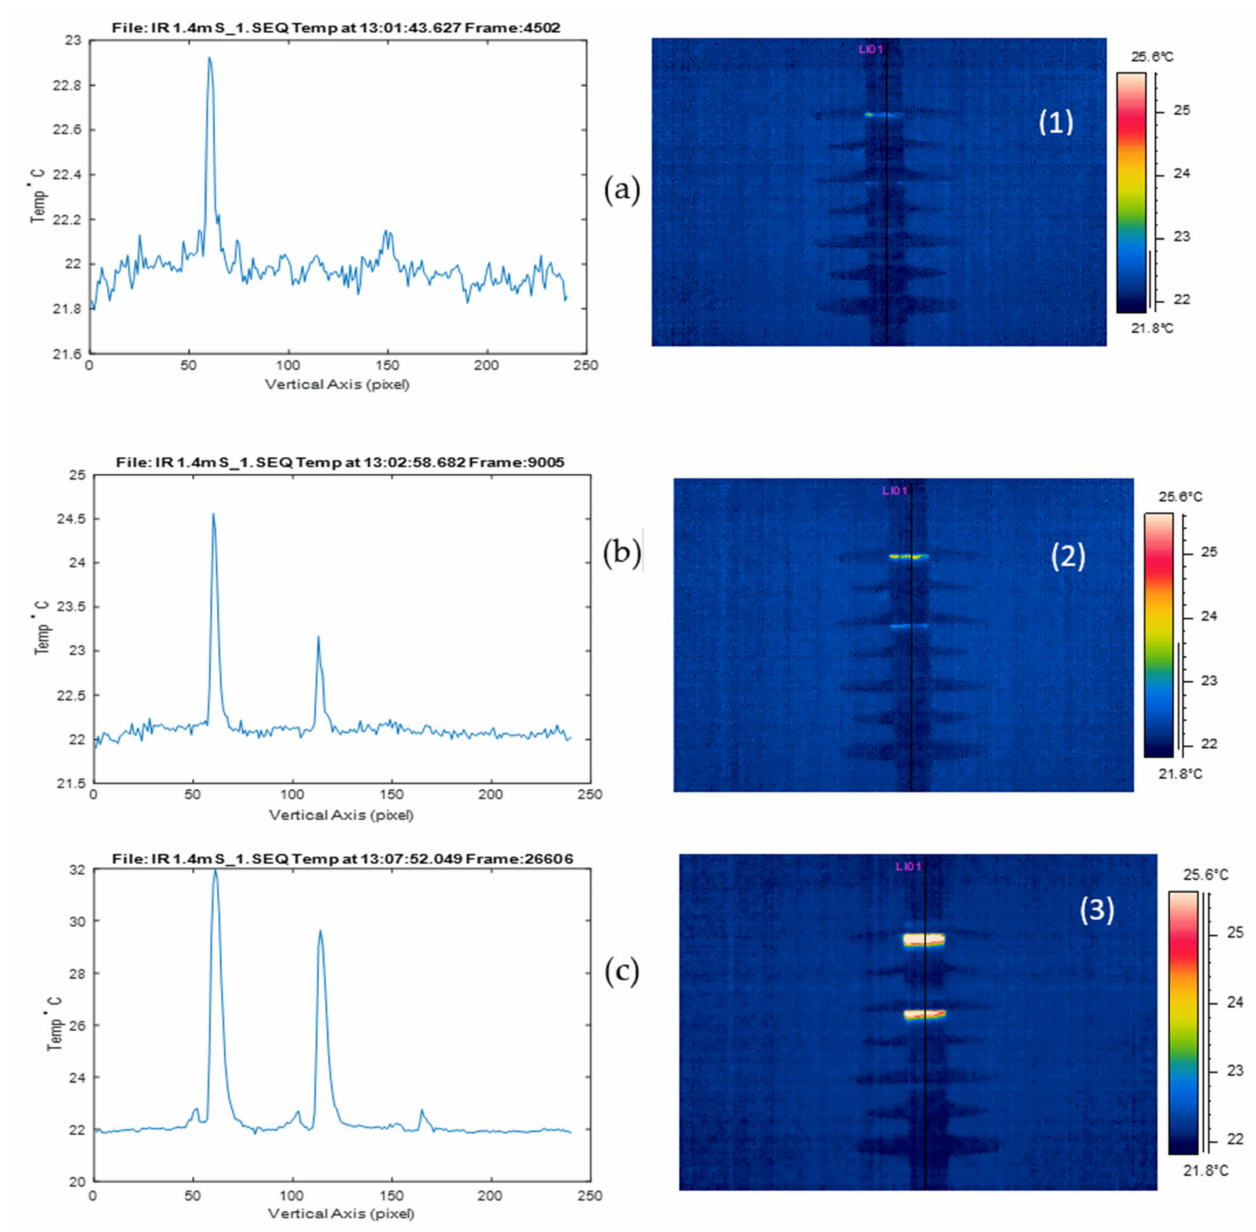
Figure 7. Thermal picture and temperature profile variation for light pollution. ( a – c ) are measured temperatures at the insulator surface. (1), (2) and (3) are the corresponding IR